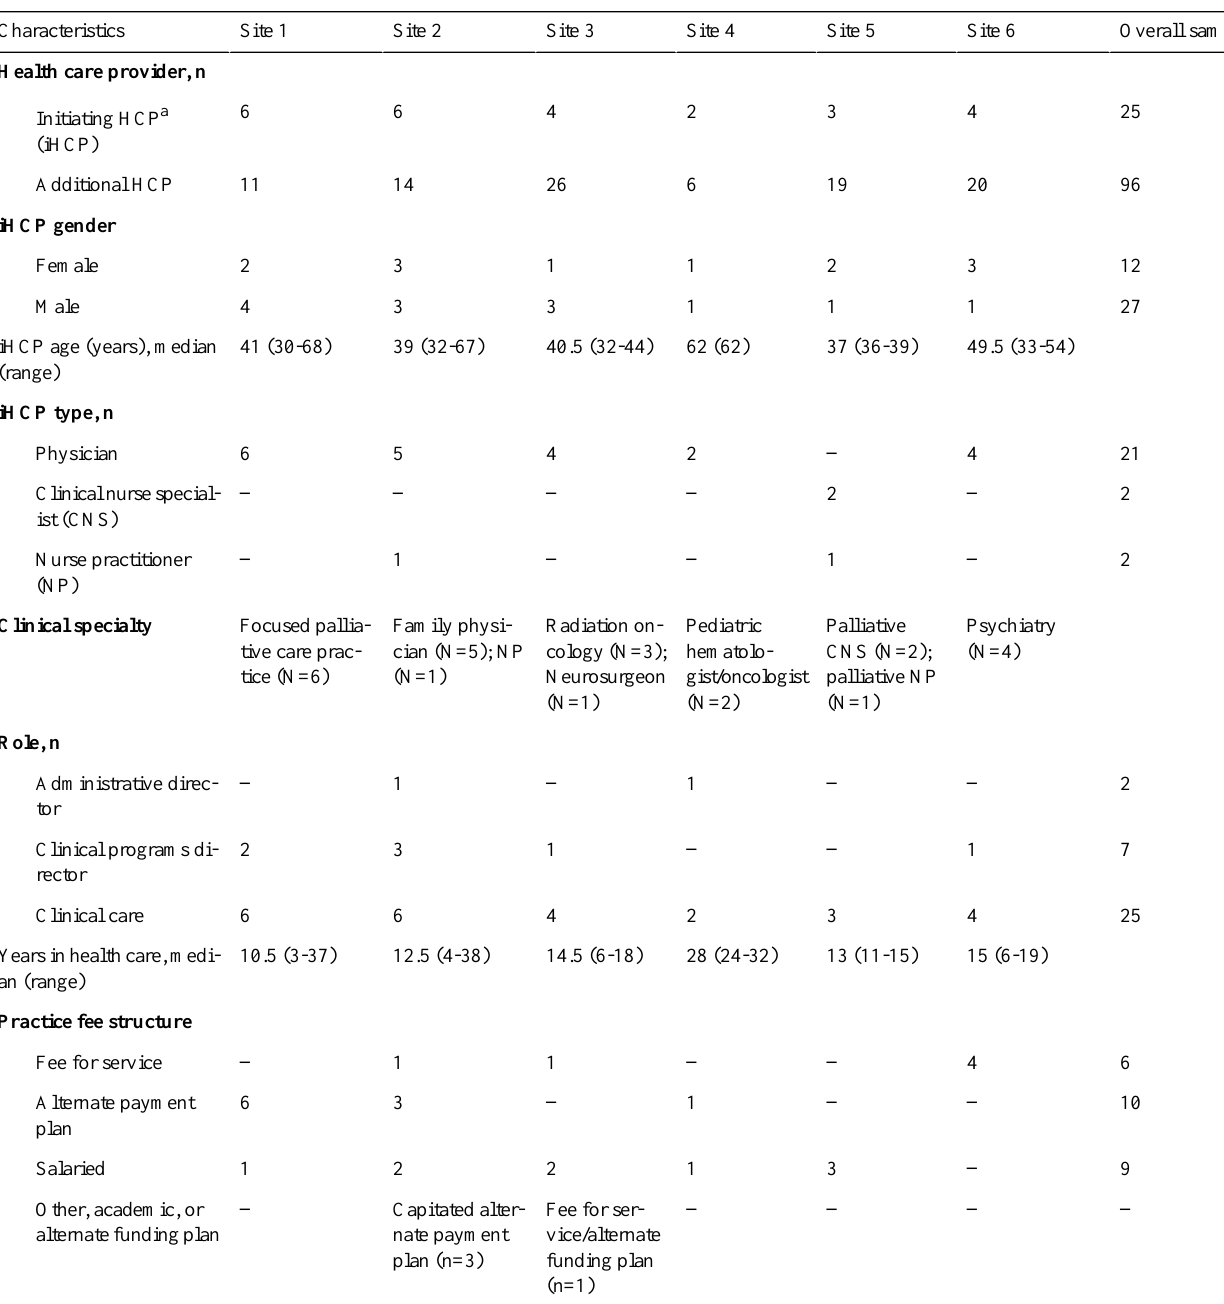
Table 3. Health care provider